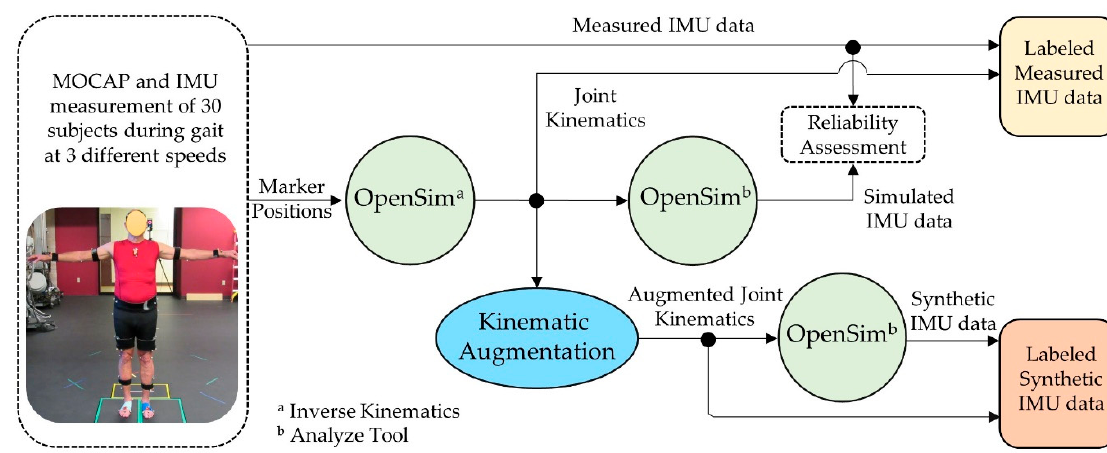
Figure 1. Overview of workflow for generating IMU signals labeled with joint kinematics. Knee and hip kinematic were calculated from measured marker positions using the Inverse Kinematic tool in OpenSim. The OpenSim analysis tool was used to generate simulated IMU data from the experimental kinematic and synthetic data from augmented joint kinematics. Simulated IMU signals from the experimental kinematics were compared with the measured IMU data to determine the reliability of the IMU simulation process.